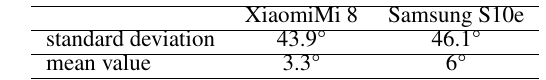
Table 2. Compass standard deviation and mean